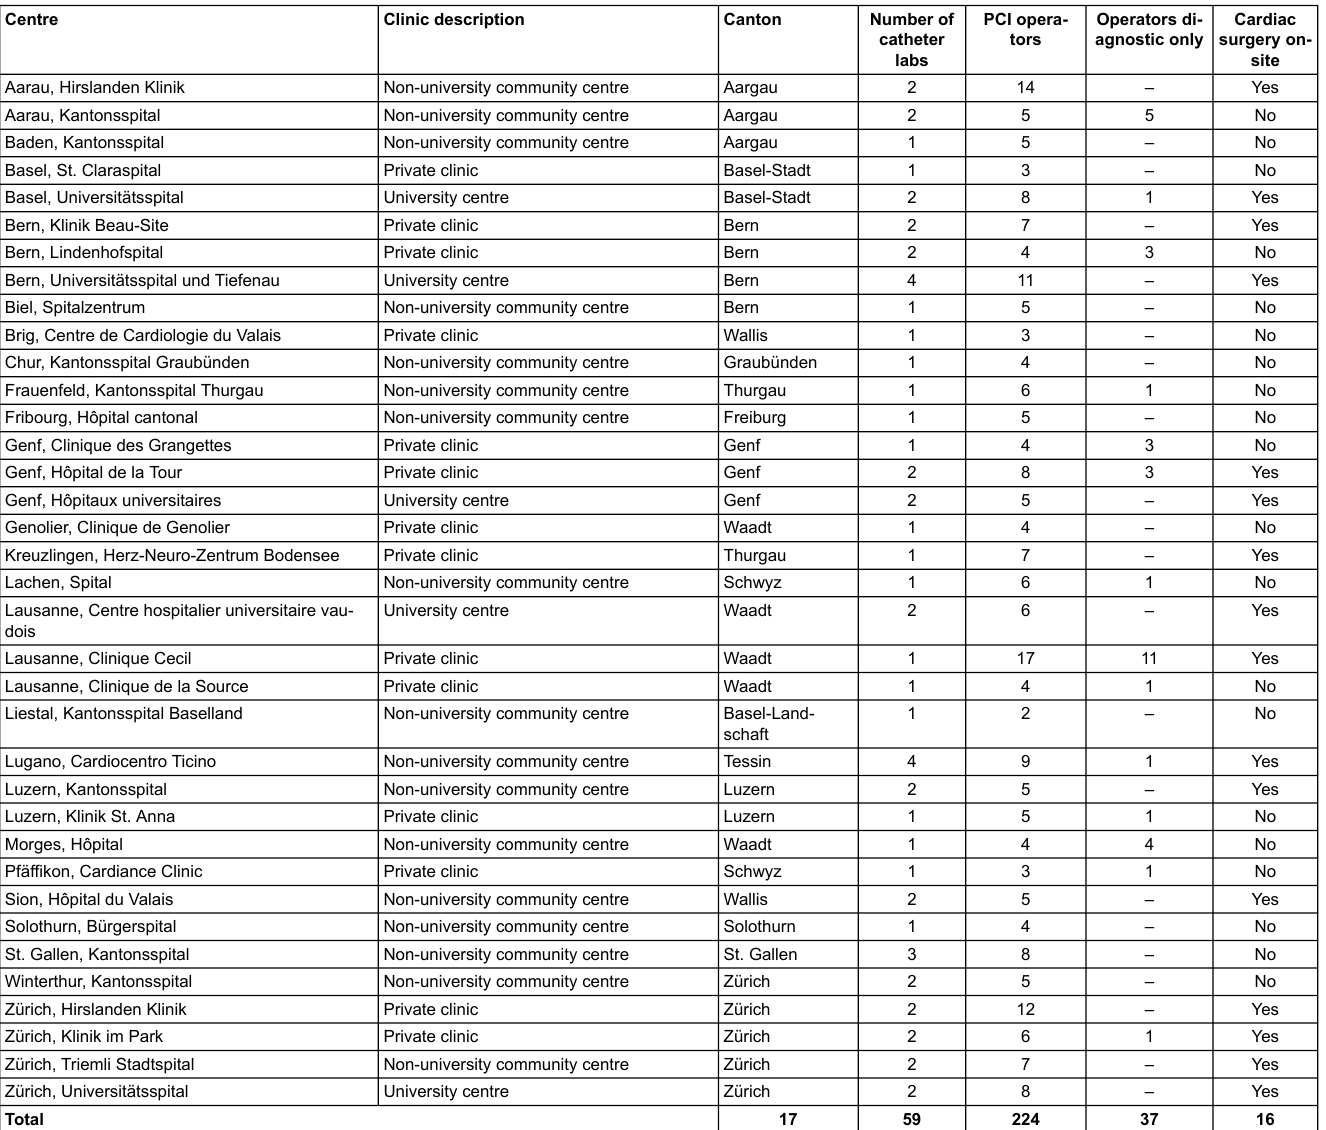
Table 1: Characteristics of the centres